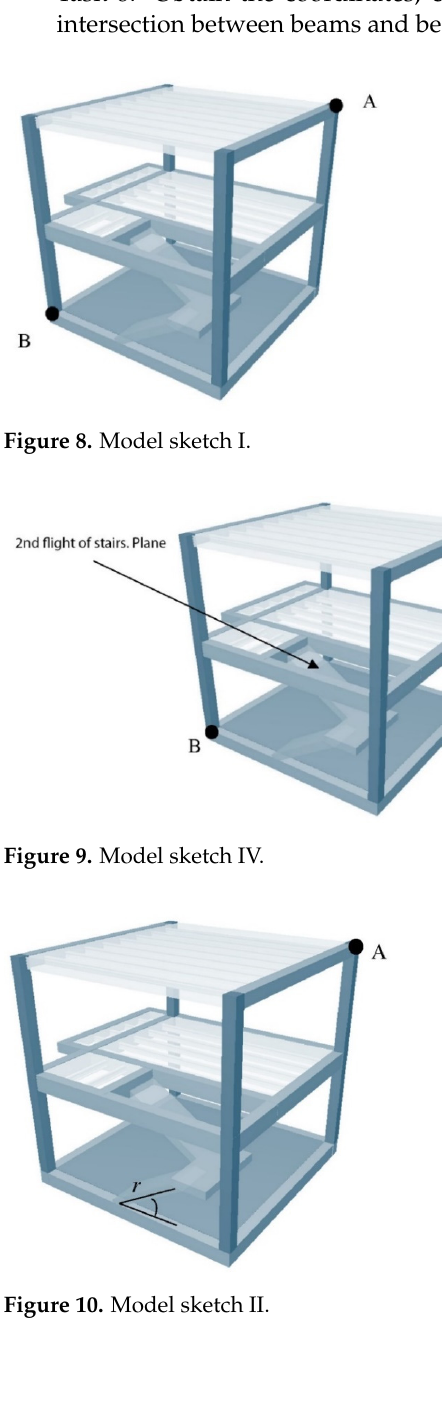
Figure 7. Wooden model of the structure of a reinforced concrete (RC) building.